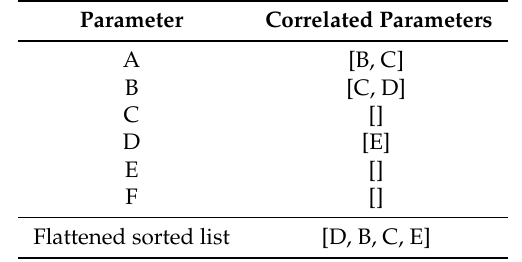
Table 4. Example step 1 and 2 in correlation analysis.